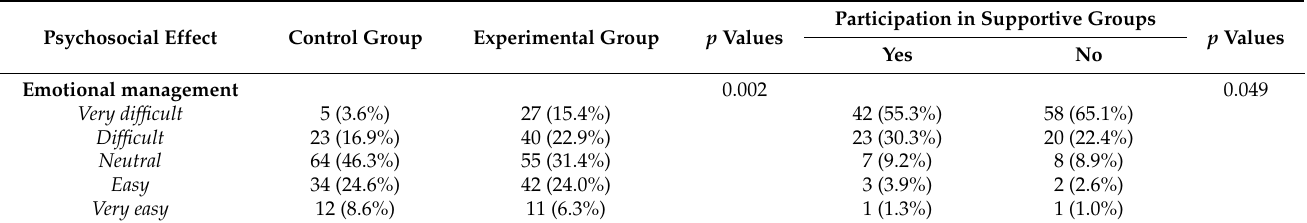
Table 4. Emotional function during the pandemic— Emotional management .